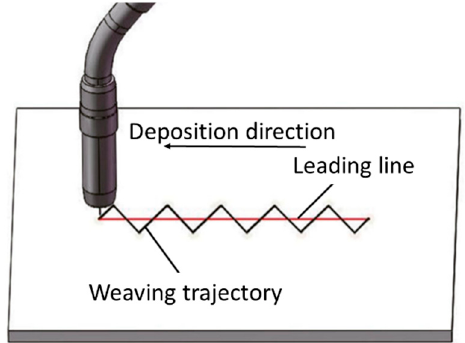
Figure 22. Weaving deposition strategy (adapted from [112]).